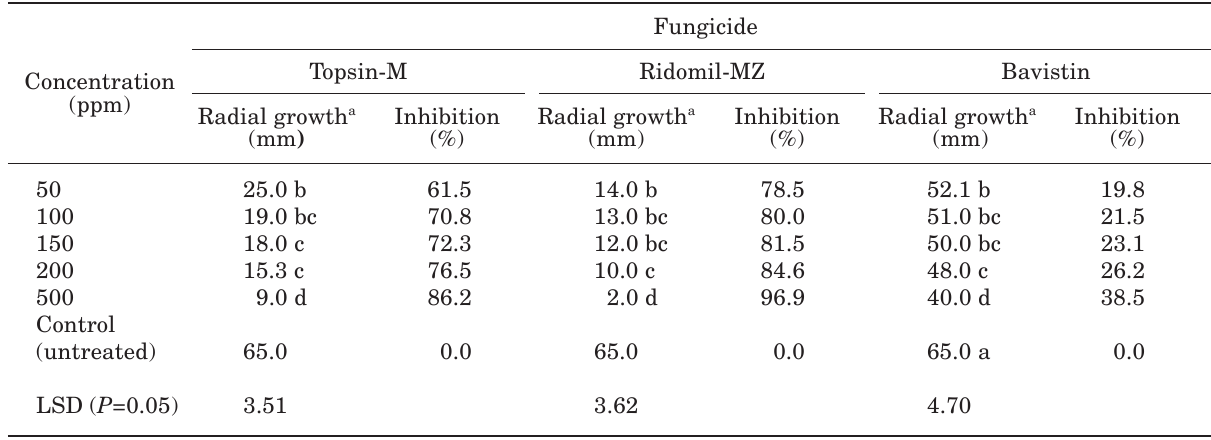
Table 2. Evaluation of systemic fungicides in vitro on radial growth of Alternaria brassicae on